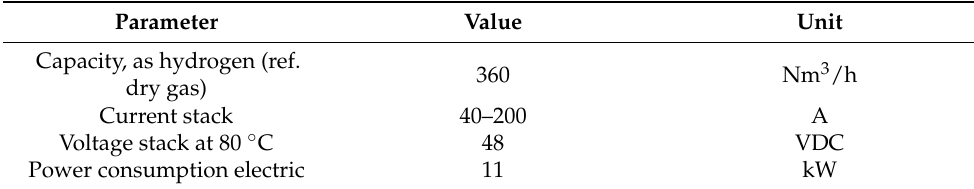
Figure 6. Scheme of an array of solar modules.